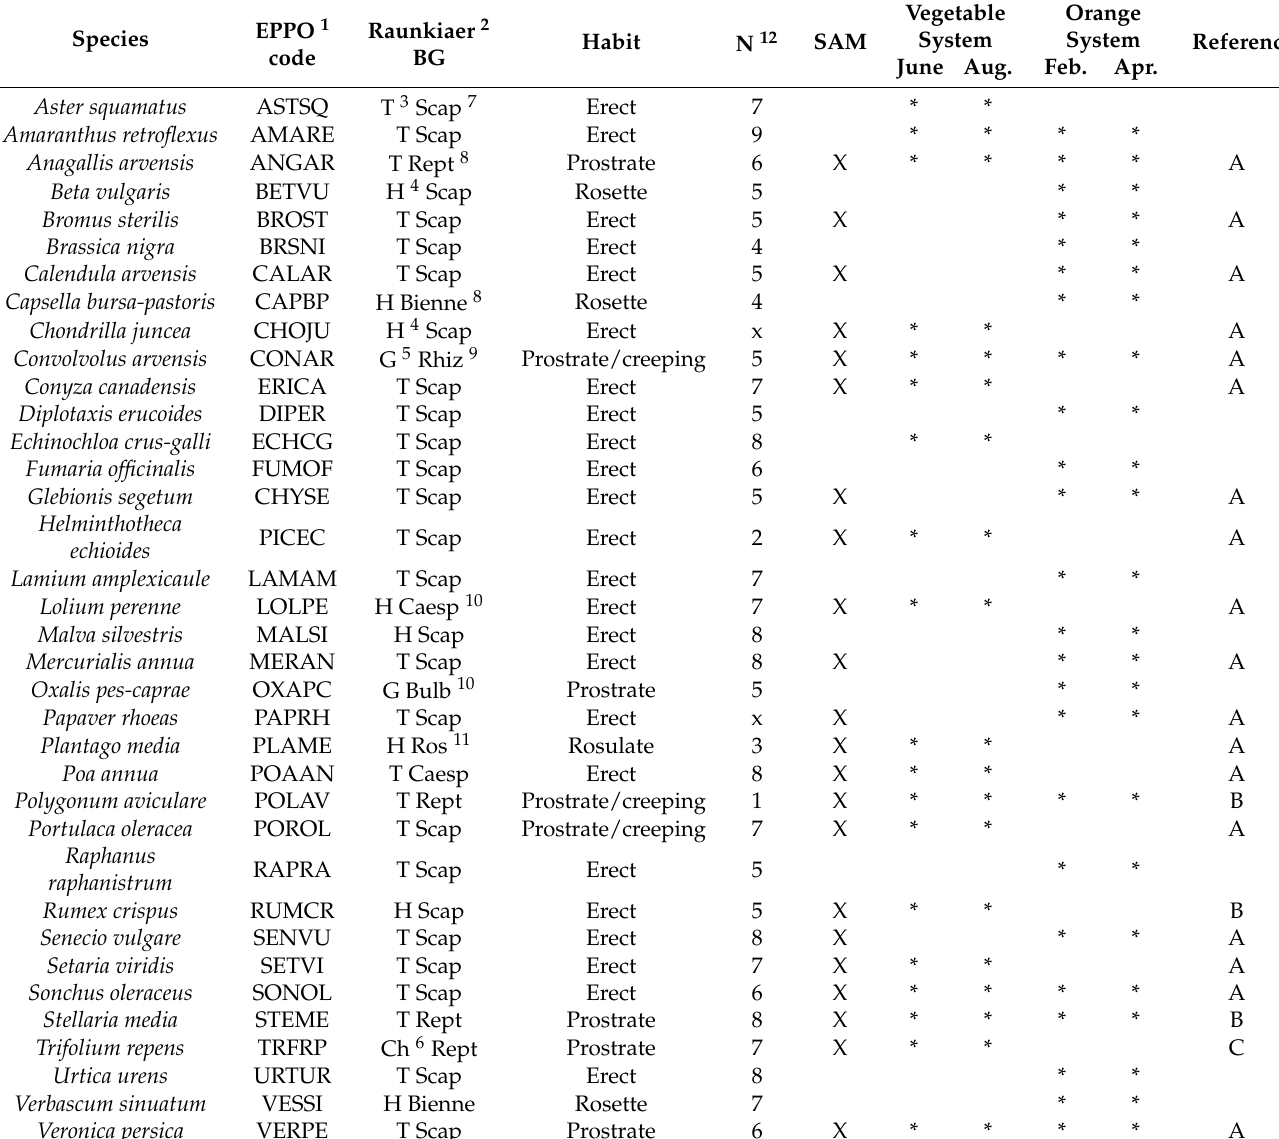
Table 1. Ecological characterization of weed species found in the vegetable (melon) and orange systems at the two sampling times per system. The cross symbol identifies those with the positive Supporting Arbuscular Mycorrhizal (SAM) trait